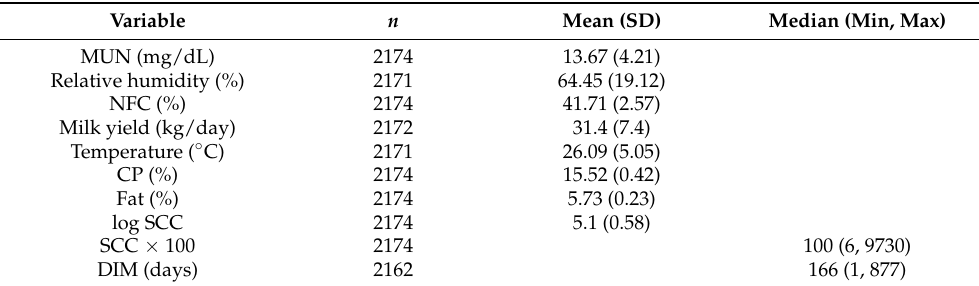
Table 1. Descriptive statistics (means and medians with standard deviations and ranges in paren- theses) for 161 Holstein cows enrolled in the study to investigate the effect of ambient temperature and relative humidity on milk urea nitrogen (MUN) concentration. Data were collected from the Experimental Farm, University of Pretoria, during the period from February 2012 to November 2017. n